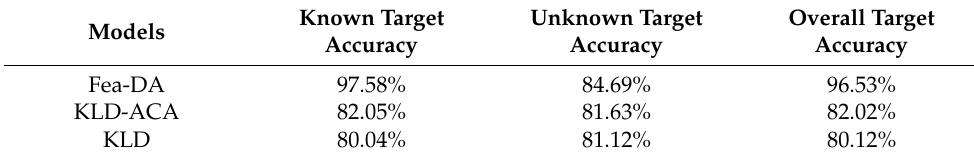
Table 8. Results of 1-type unknown target test on Fea-DA, KLD-ACA and KLD models.